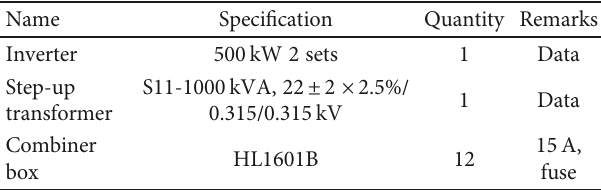
Table 4: Description of solar array system.